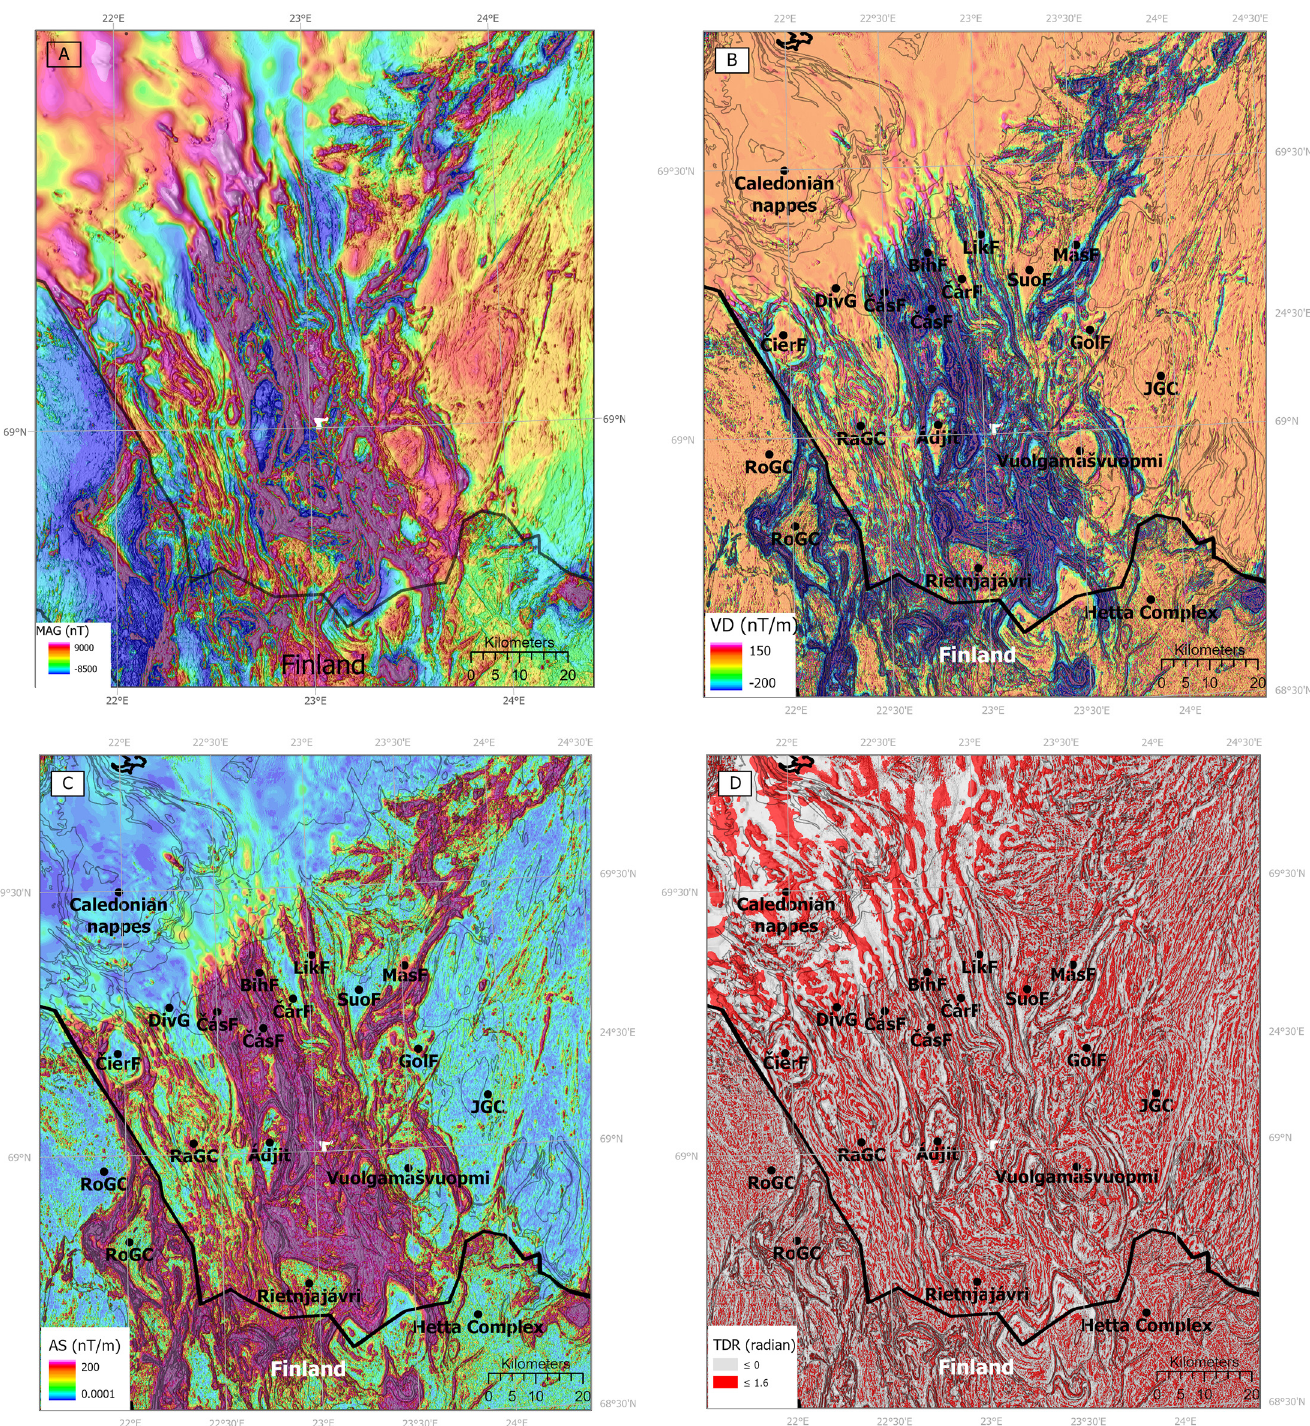
Figure 8. Magnetic anomaly maps. (A) Reduced to pole magnetic data (RTP). Data compiled from NGU and GTK. (B) The first vertical derivative of the aero- magnetic data. (C) Analytical signal of magnetic data. (D) Positive tilt derivative values of the magnetic data. BihF= Bihkkačohkka Formation, ČárF= Čáravárri Formation, ČásF= Čáskejas Formation, ČierF= Čierte Formation, DivG= Dividal Group, GolF= Goldenvárri Formation, JGC= Jergul Gneiss Complex, LikF= Likčá Formation, MasF= Masi Formation, RaGC= Ráiseatnu Complex, RoGC= Rommaeno Gneiss Complex, SuoF= Suolovuopmi